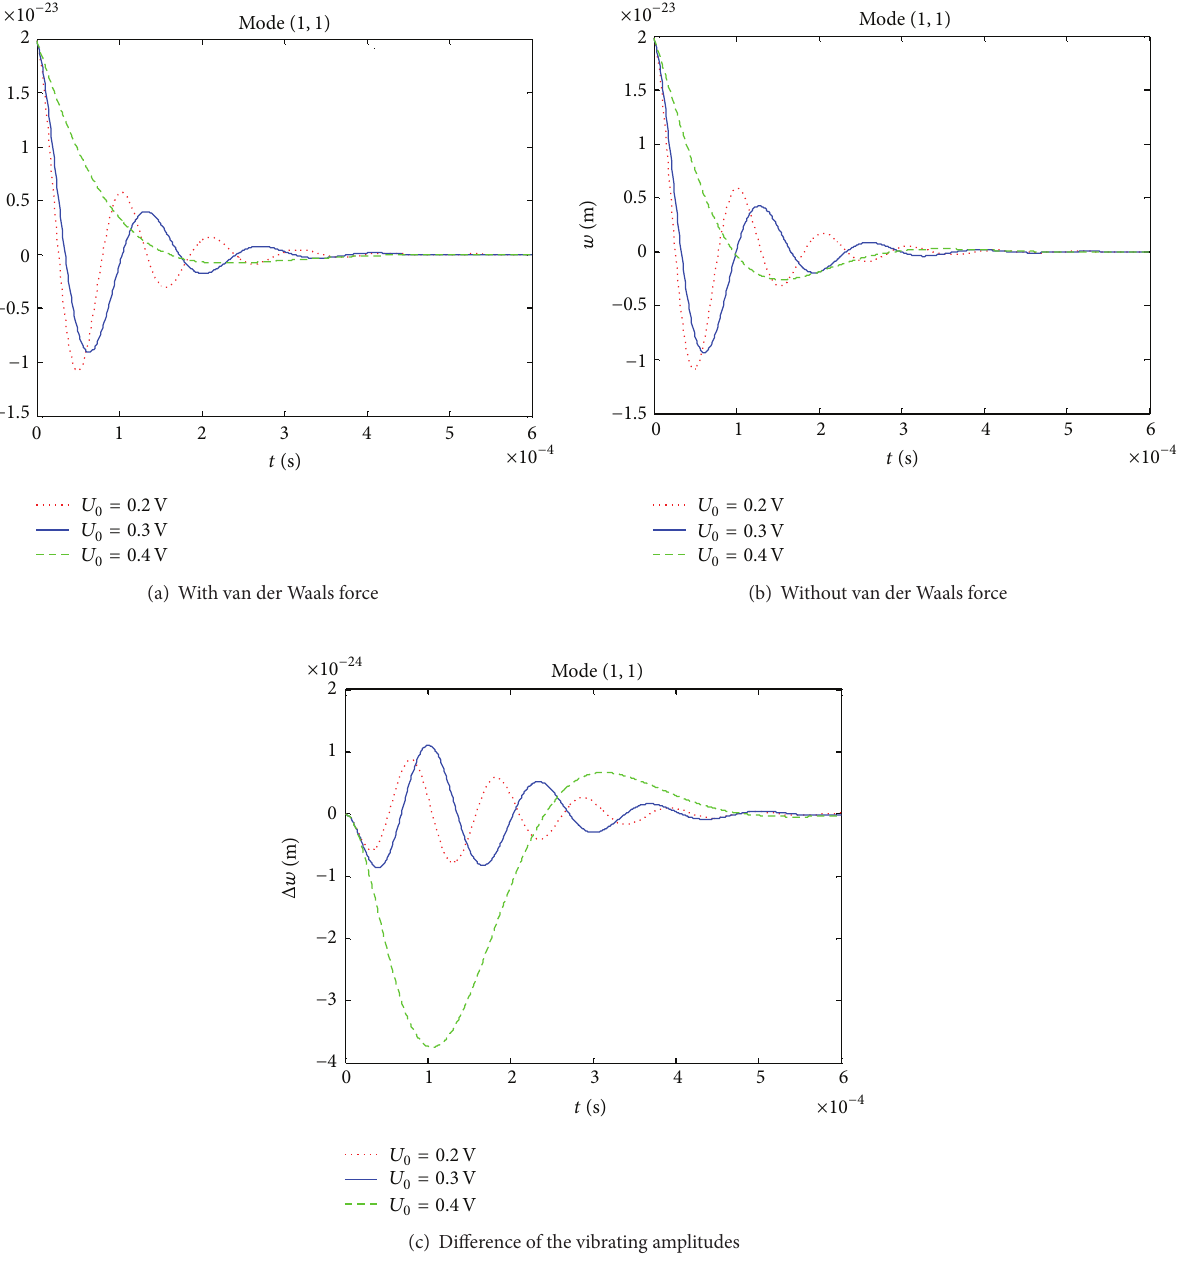
Figure 6: Effects of the van der Waals force on vibrating amplitude of the film center for various 𝑈 0 .